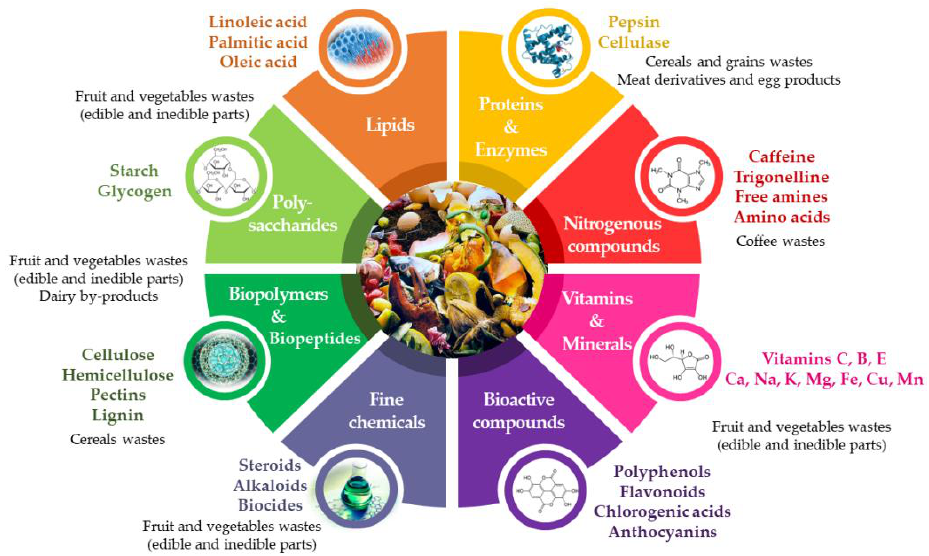
Figure 3. Overview of the different types of bioactive compounds that can be obtained from food wastes.